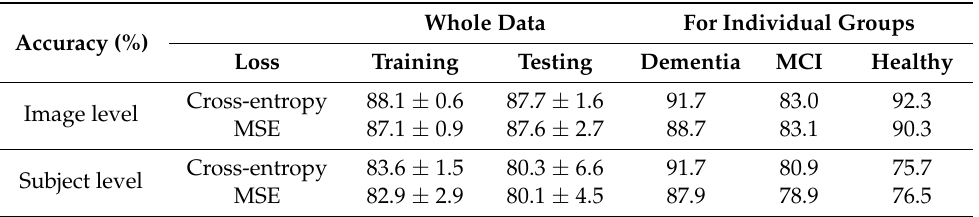
Table 3. Performance of EPVS rating estimation model on whole data and for individual groups (testing and training accuracy is reported as mean ± standard deviation).